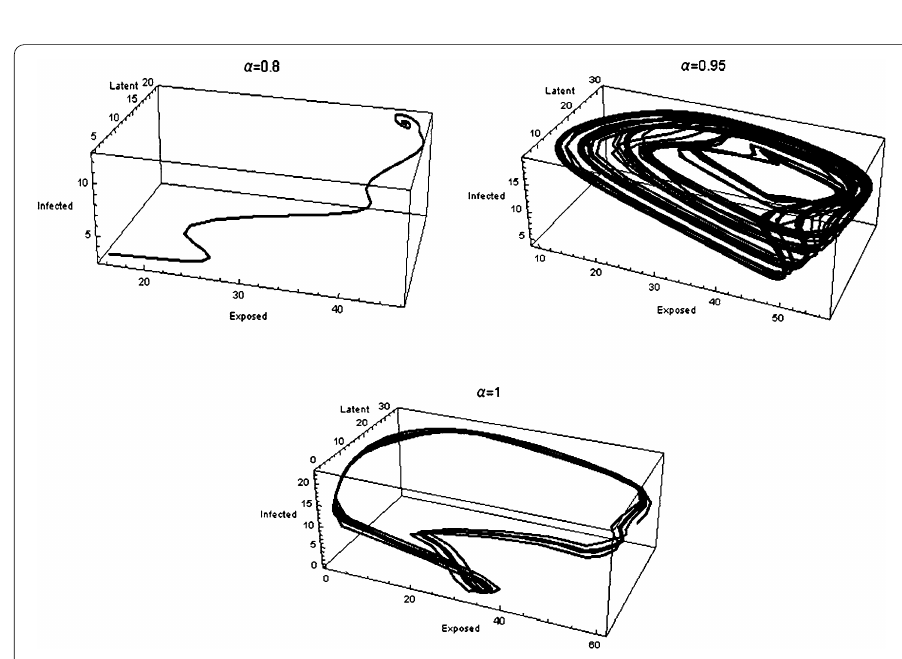
Figure 6 The phase diagrams of SVELITR at different values of α for R 0 > 1 and τ = 3 > τ